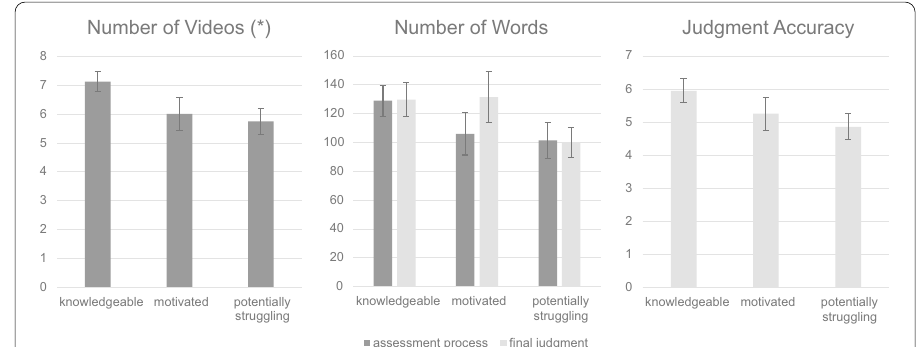
Fig. 3 Profiles’ means and standard errors regarding the assessment process (dark gray) and final judgment (light